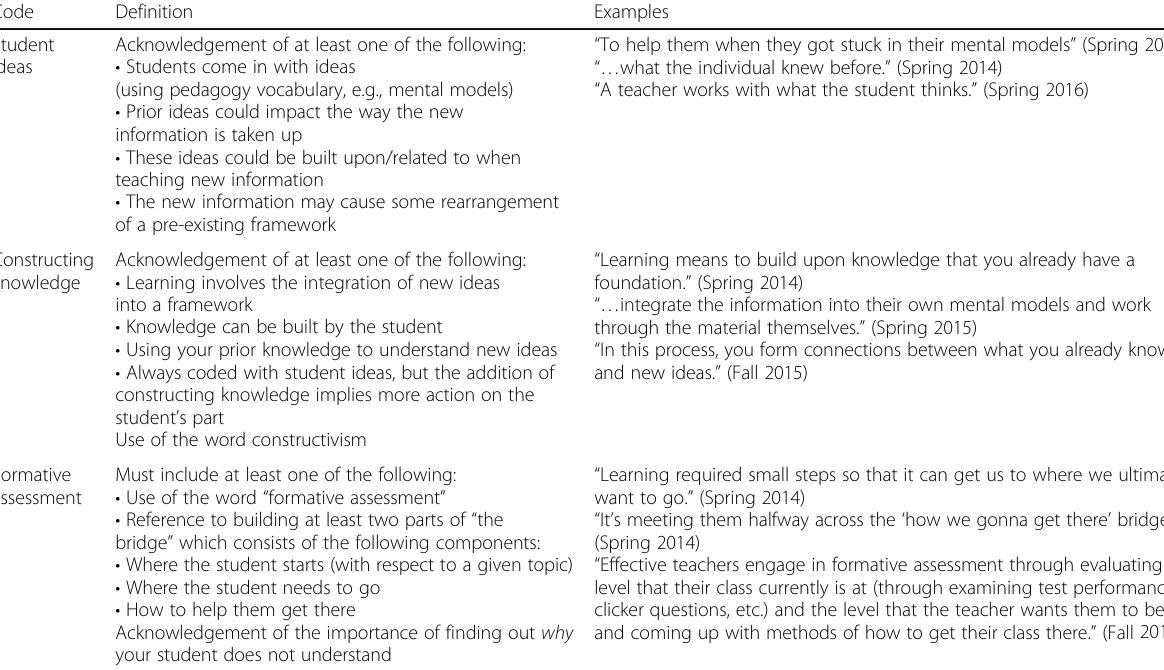
Table 2 Summary of primary codes used to analyze LA teaching